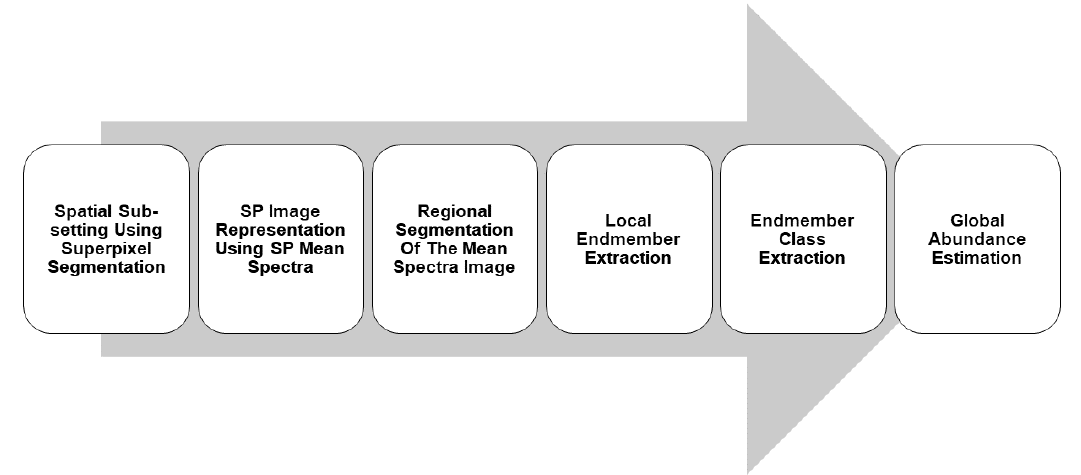
Figure 9. Proposed unsupervised superpixel-based hyperspectral unmixing with regional